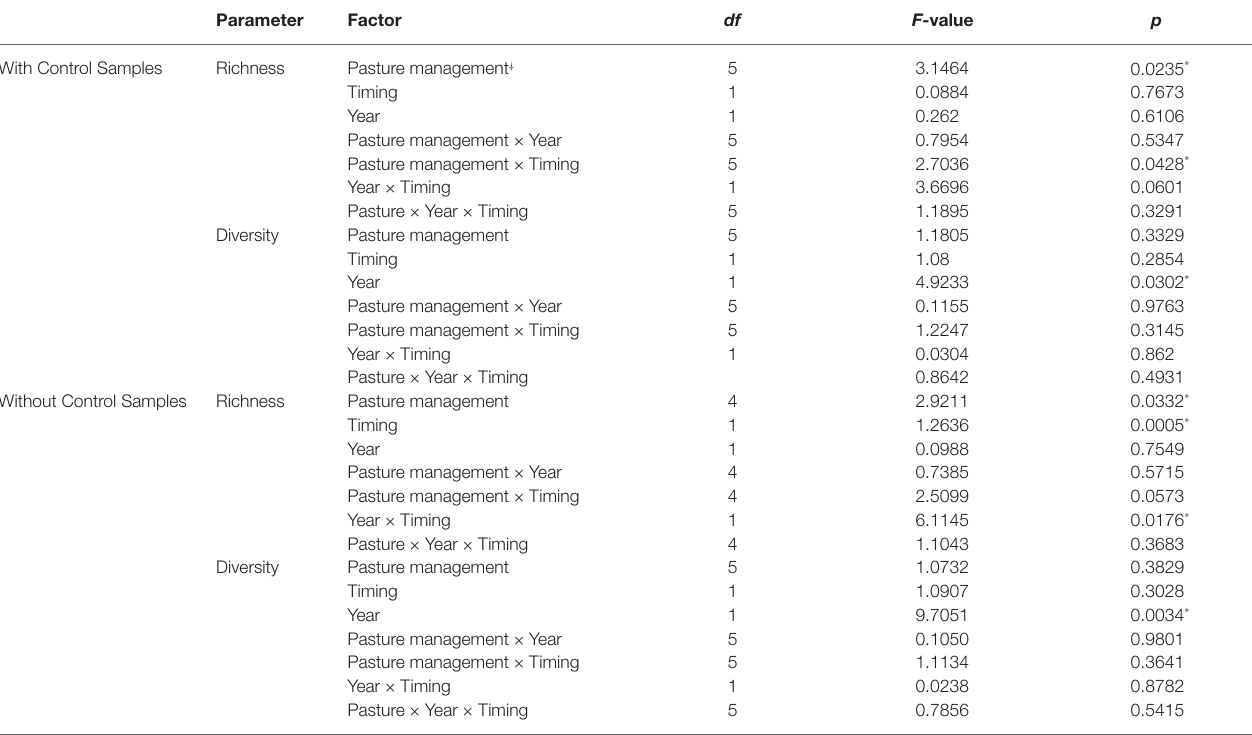
TABLE 1 | ANOVA of richness (Chao1) and diversity (Shannon) in alpha diversity influenced by pasture management and year following 13 years of pasture management and year.